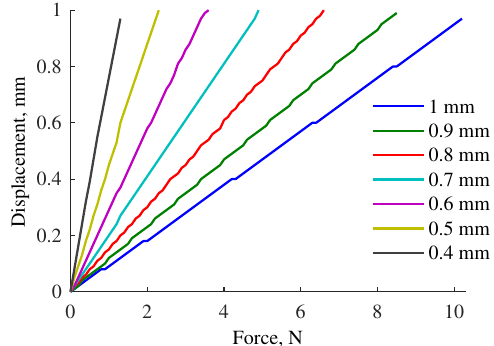
Figure 7. Force–displacement relationship obtained for different configurations of ortho-planar